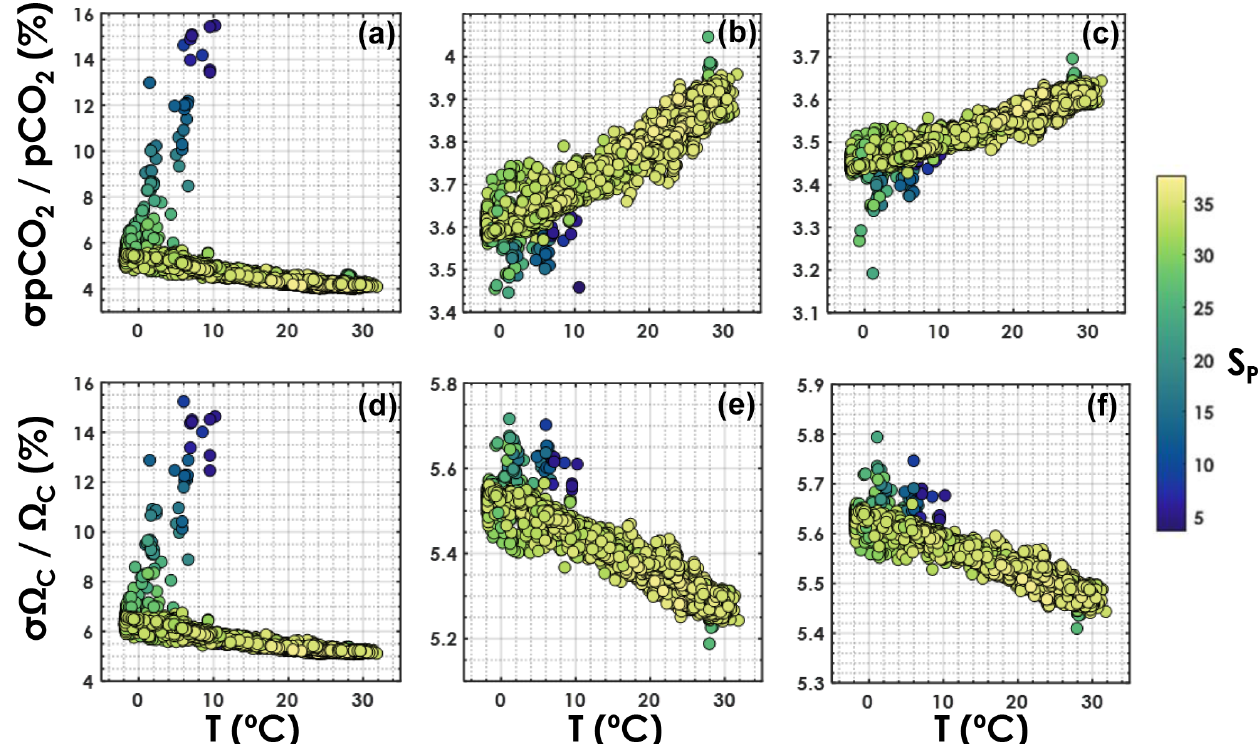
Figure 5. Overall relative uncertainty for (a, b, c) p CO 2 and (d, e, f) (cid:127) Ca as a function of in situ temperature (horizontal axis) and salinity (colour bar). Panels (a, d) are for the TA–DIC pair, panels (b, e) are for the TA–pH pair, and panels (c, f) are for the DIC–pH pair. This is computed using all data points from GLODAPv2 that contain T , P , S P , DIC, TA, pH, [SRP], and [DSi], in the top 10m of the water column (3392 samples).